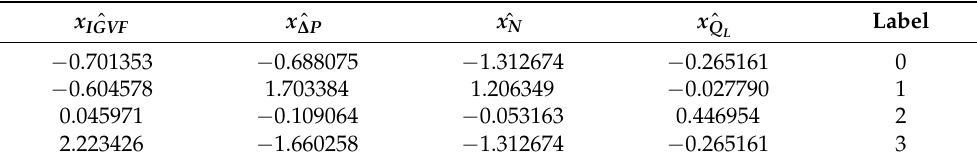
Table 6. Some sample points after data